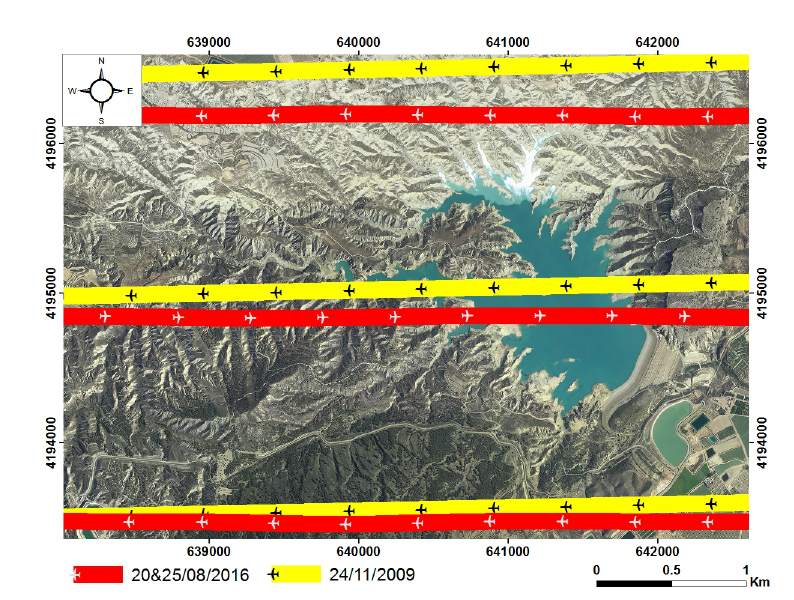
Figure 7. LiDAR flight